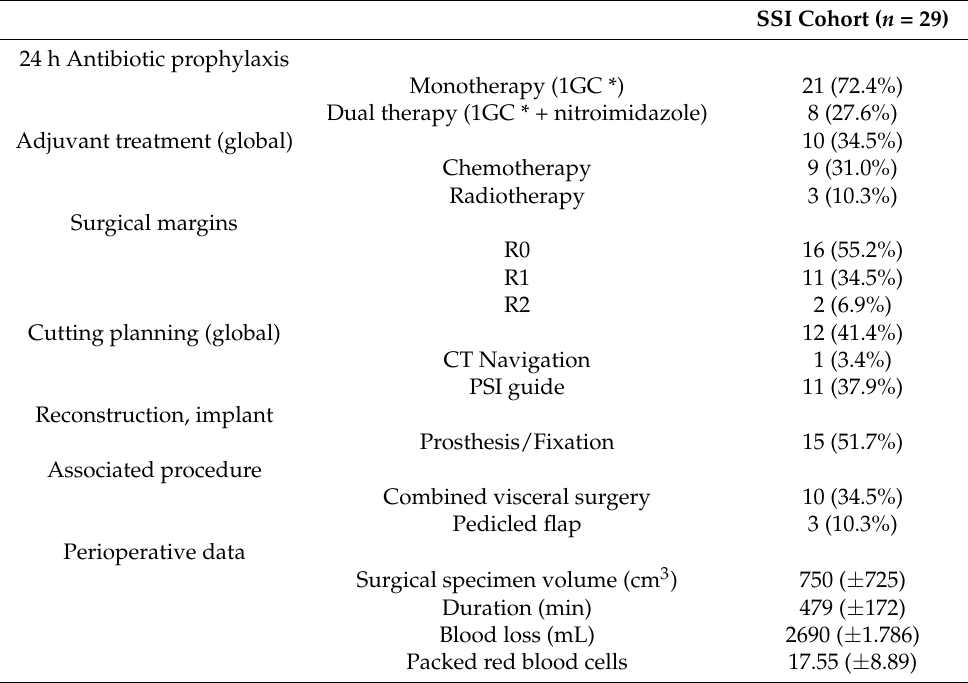
Table 2. Resection surgery data for the SSI